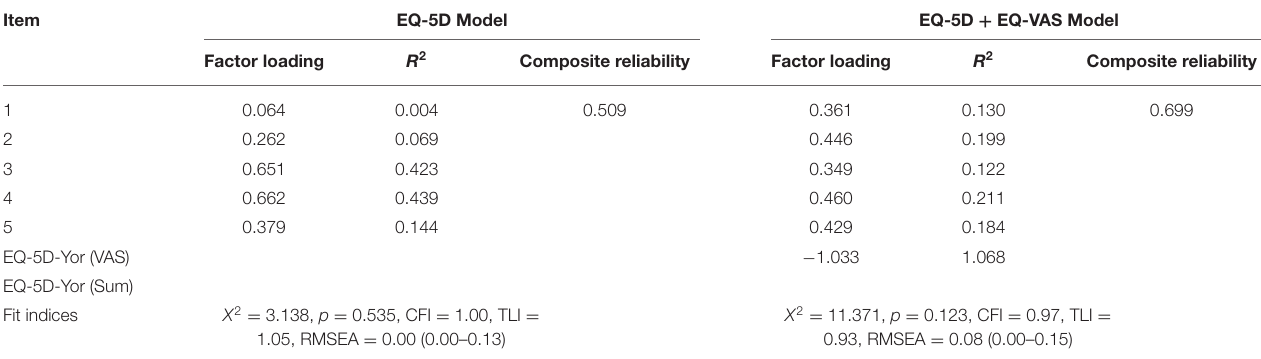
TABLE 4 | Confirmatory factor analysis of the EQ-5D-Y questionnaire.